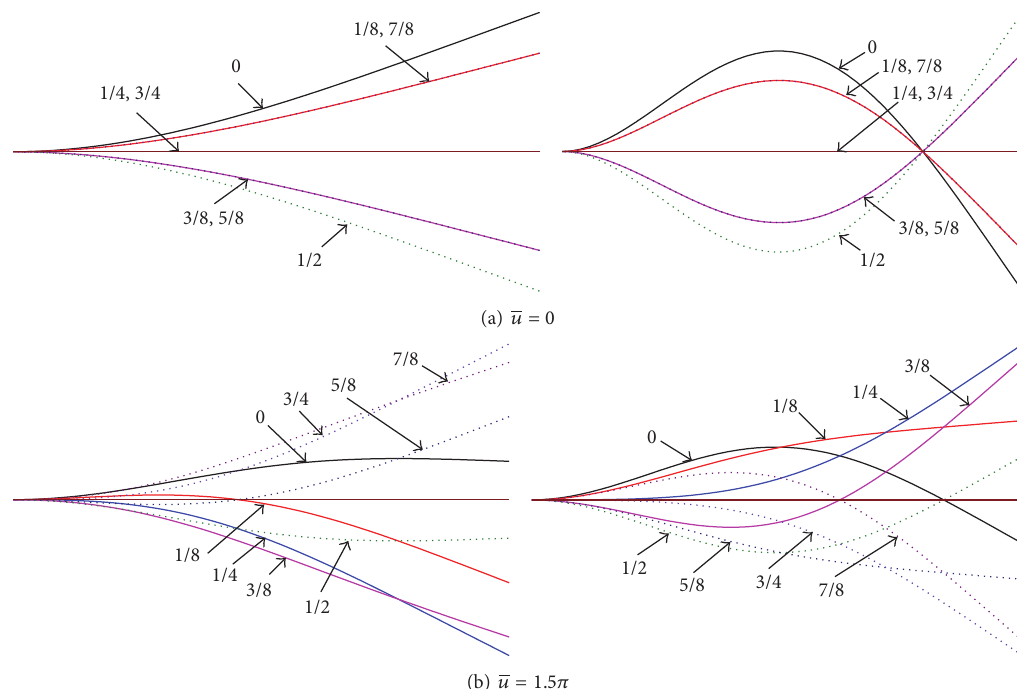
Figure 5: Variation of modal forms of the first two modes of a clamped-free pipe during a period of oscillation.